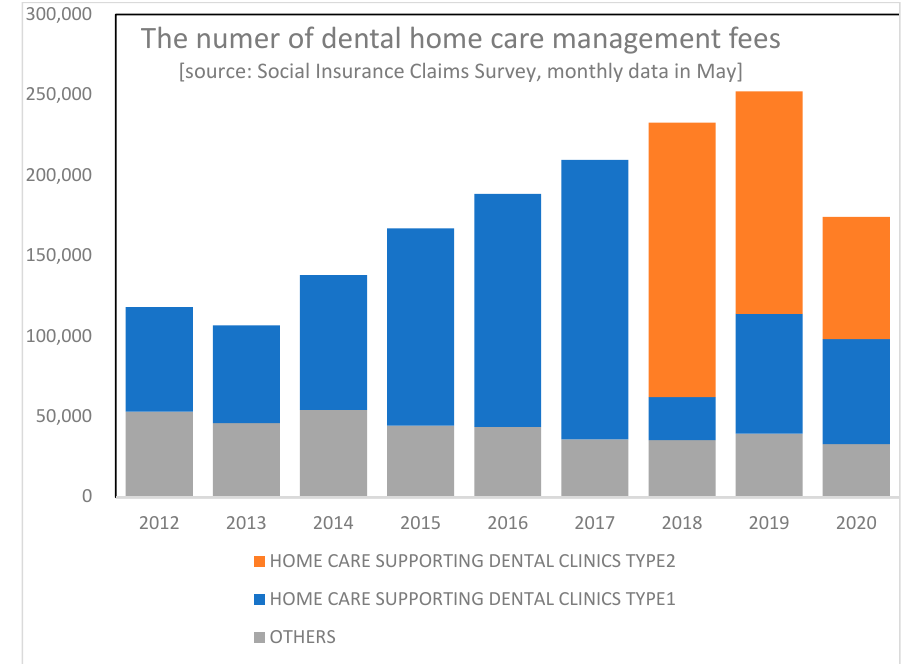
Figure 3. The number of dental home care management fees.